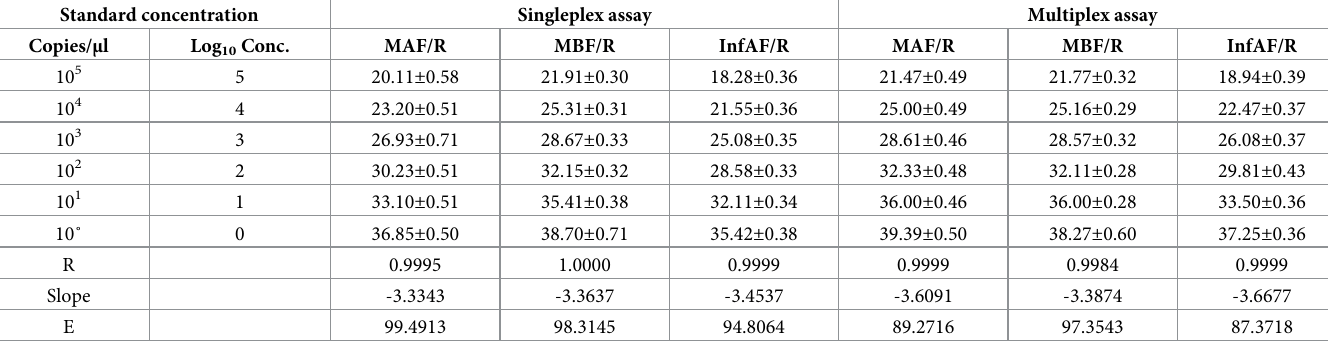
Data (C T values) are presented as the mean ± standard deviation. The correlations of data obtained from multiplex assays and singleplex assays were analyzed by Pearson correlation. Data obtained from multiplex assays and singleplex assays were compared using independent sample t-test and no significances were detected. R, correlation coefficient; E, amplification efficiencies of the